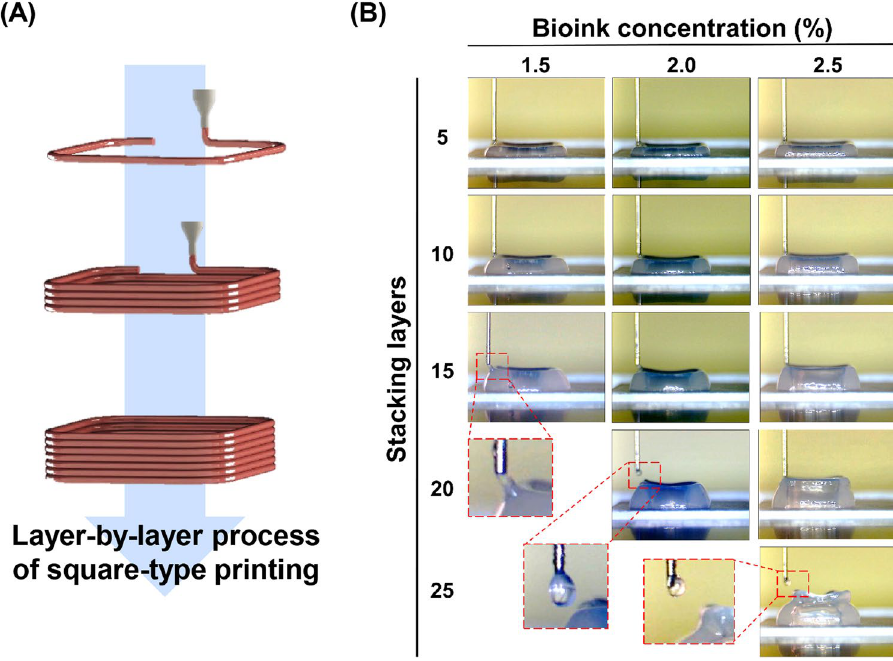
Figure 4. 3D stacking process. ( A ) Schematic illustration of layer-by-layer process for 3D printing, and ( B ) 3D stacking results of bioinks with different